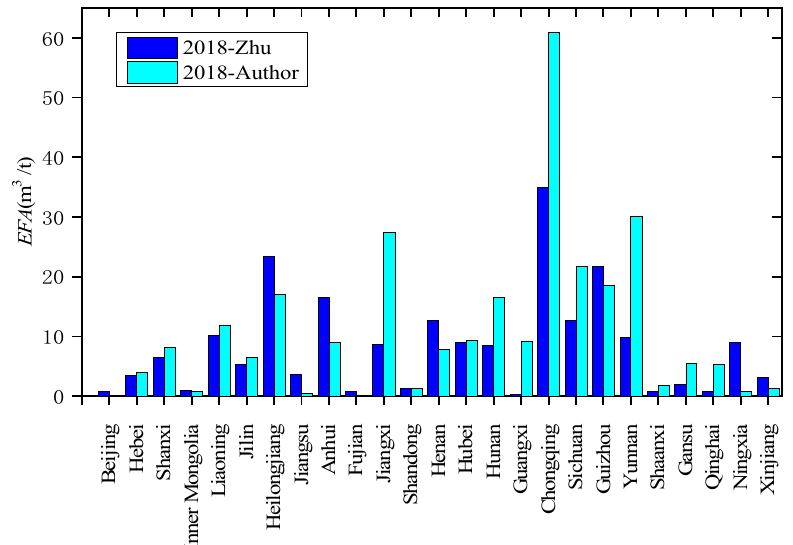
Figure 2. Comparison of CH 4 emission factors calculated in this paper and those predicted by Zhu et al. [18].